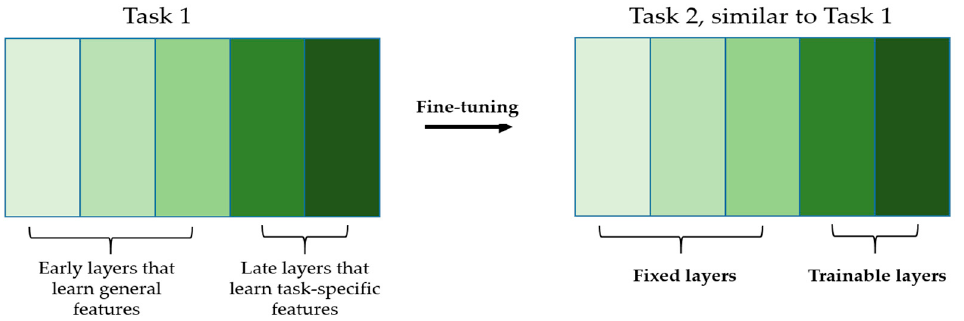
Figure 6. Illustration of fine-tuning. Only the late layers will be trainable during the fine-tuning. The different shades of green indicate how the specificity of the features increases layer after layer. From left to right, we have the general features to the task-specific features.